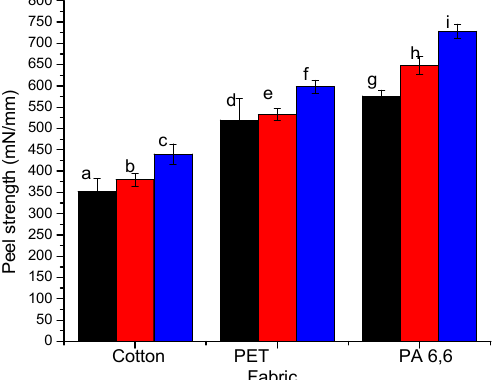
Molecules 2020 , 25 , x FOR PEER REVIEW Figure 10. Peel strength for cotton, PET, and PA 6,6 fabrics adhered using NCC: ( a , d , g ) NCC with no additives, ( b , e , h ) NCC+PEI, and ( c , f , i ) NCC+P(GMA-OEGMA) mixtures.